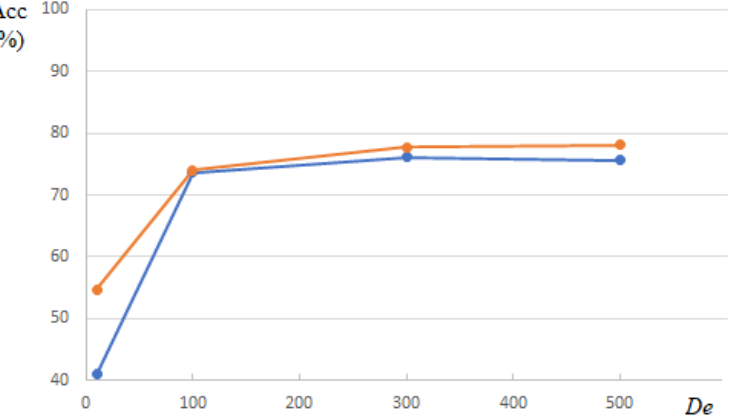
Figure 3. Testing accuracy obtained by different embedding dimensions, for English ( red ) and Italian ( blue ).